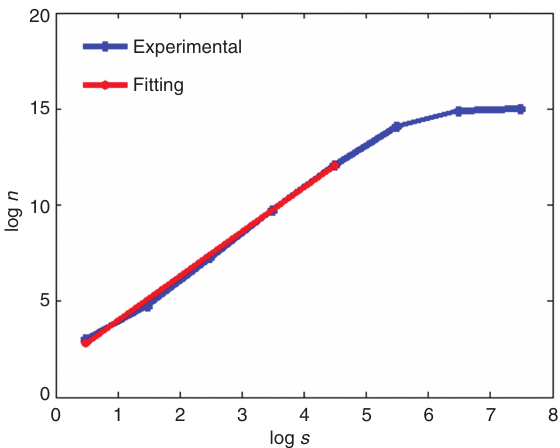
Figure 5: The logarithm of the number of boxes log( n ) against the logarithm of the box size value of log( s ) (blue line). The estimation of the fractal dimension D of Figure 3A corresponds to the best linear fitting of the slope (red line).